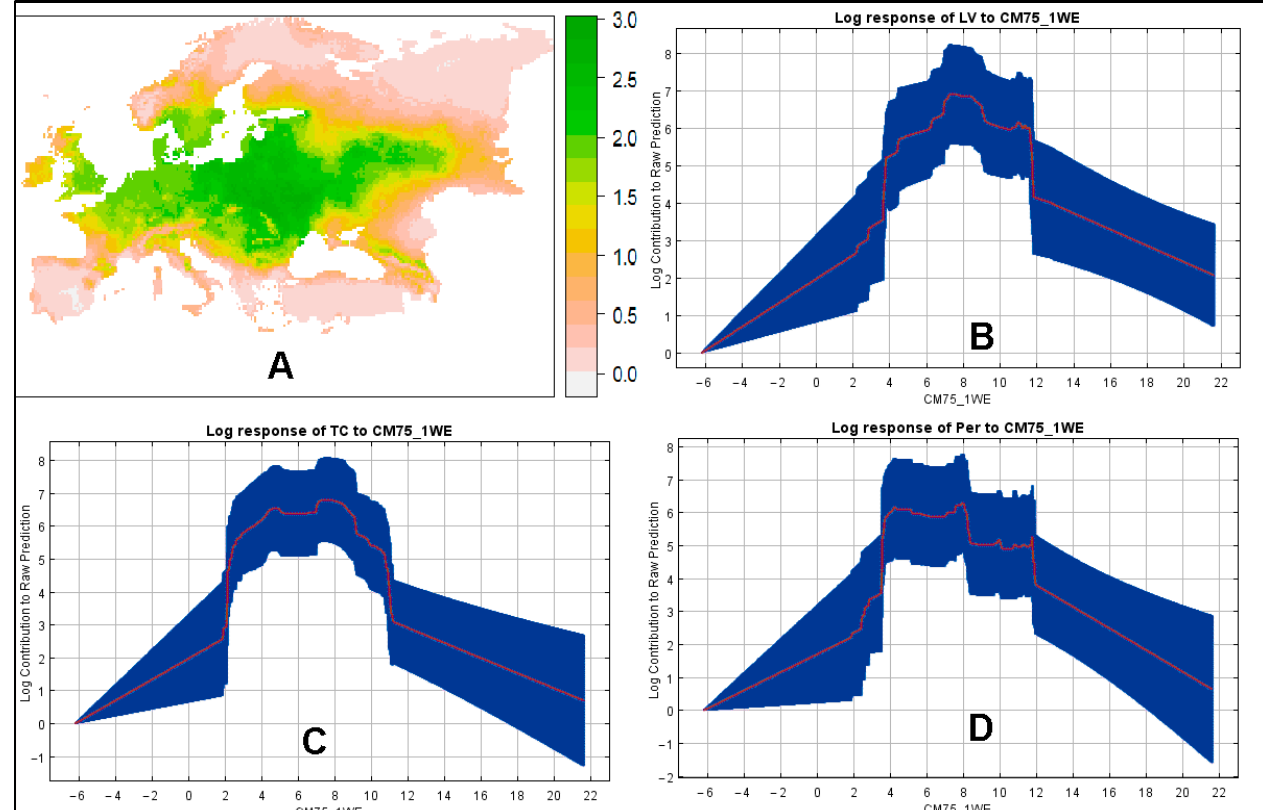
Figure 2. Map of the Maxent model: ( A )—Map of the cohabitation of 3 species (SDM) in Europe; and the plots of response curves of the Maxent model using only the Bio01 variable—Annual mean temperature (°C, CliMond) from: ( B )— L. vulgaris ; ( C )— T. cristatus ; ( D )— P. glenii .